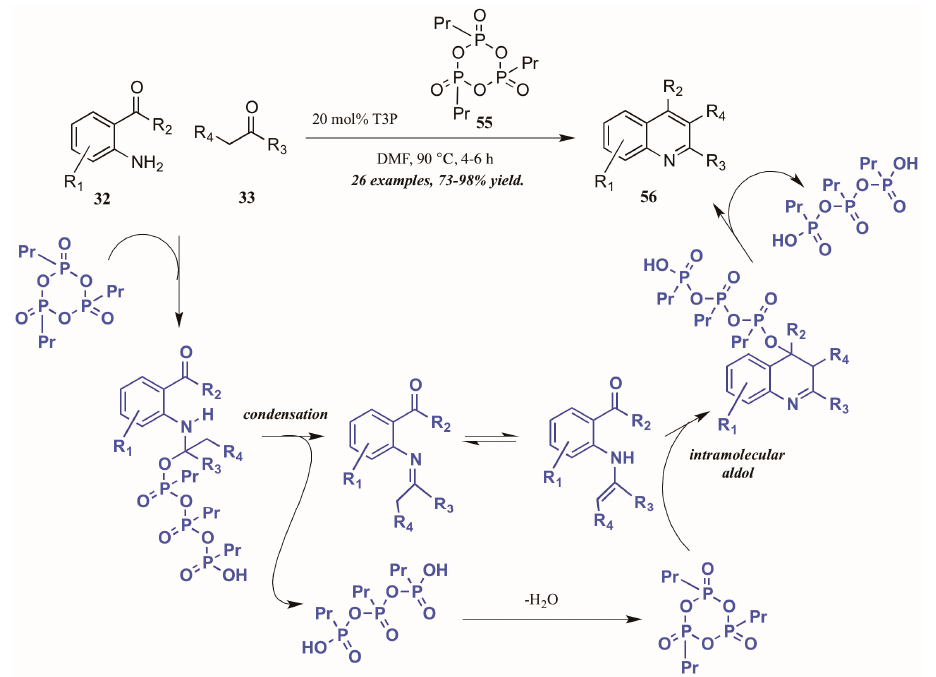
Figure 25. Ionic liquid acid-catalyzed Friedländer quinoline synthesis.